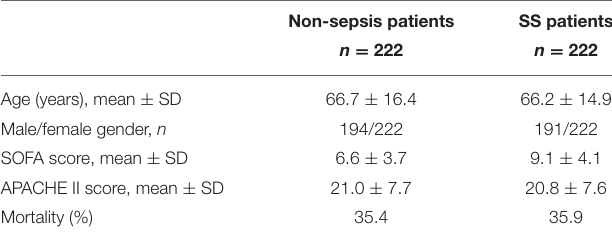
TABLE 2 | Propensity score-matched patients with severe sepsis and without any evidence of sepsis in the validation cohort (post-matching